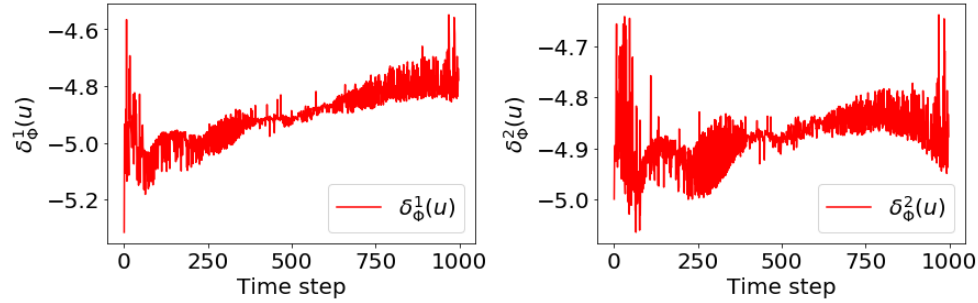
Figure 19. (Data-targeted VAE) First component ( left ) and second component ( right ) of log ( s 2 ( u h ( t i ) , Φ )) with respect to the time step i = 1, . . . , M